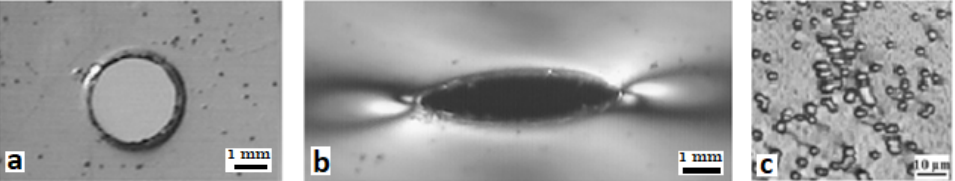
Figure 1. ( a ) Modeling of the pore with a 0.3 mm hole drilled into the polyimide film; ( b ) distortion of the hole shape at a tensile rate of 2 mm/min to 100% deformation; ( c ) elongation of the pore shape of the TM with d = 4 μ m and n = 10 6 cm − 2 at a 10% deformation. A comparison of the photographs in Figure 1a,b allows us to see the hole evolution in the process of single-axis